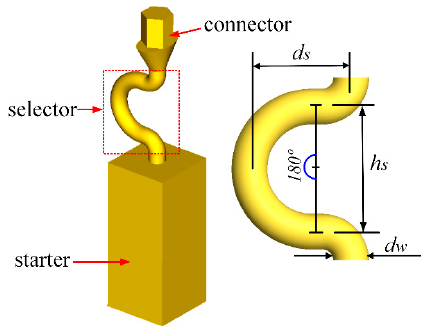
Figure 1. Schematic drawings of the new 2D grain selector and its selector part showing parameters used in the selector part.